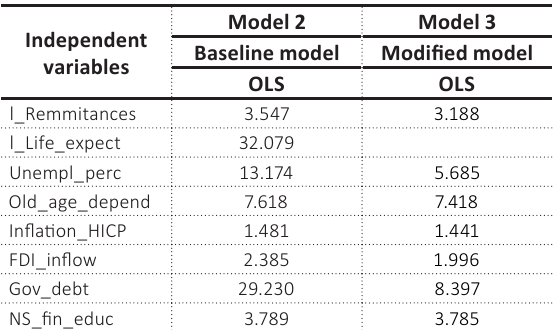
Table 4. Collinearity test: variance inflation factors